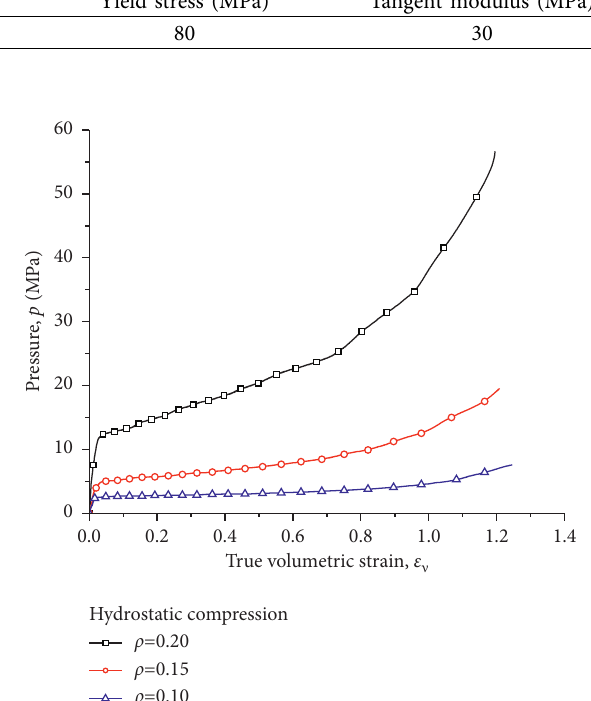
Figure 11: Hydrostatic pressure and the true volumetric strain